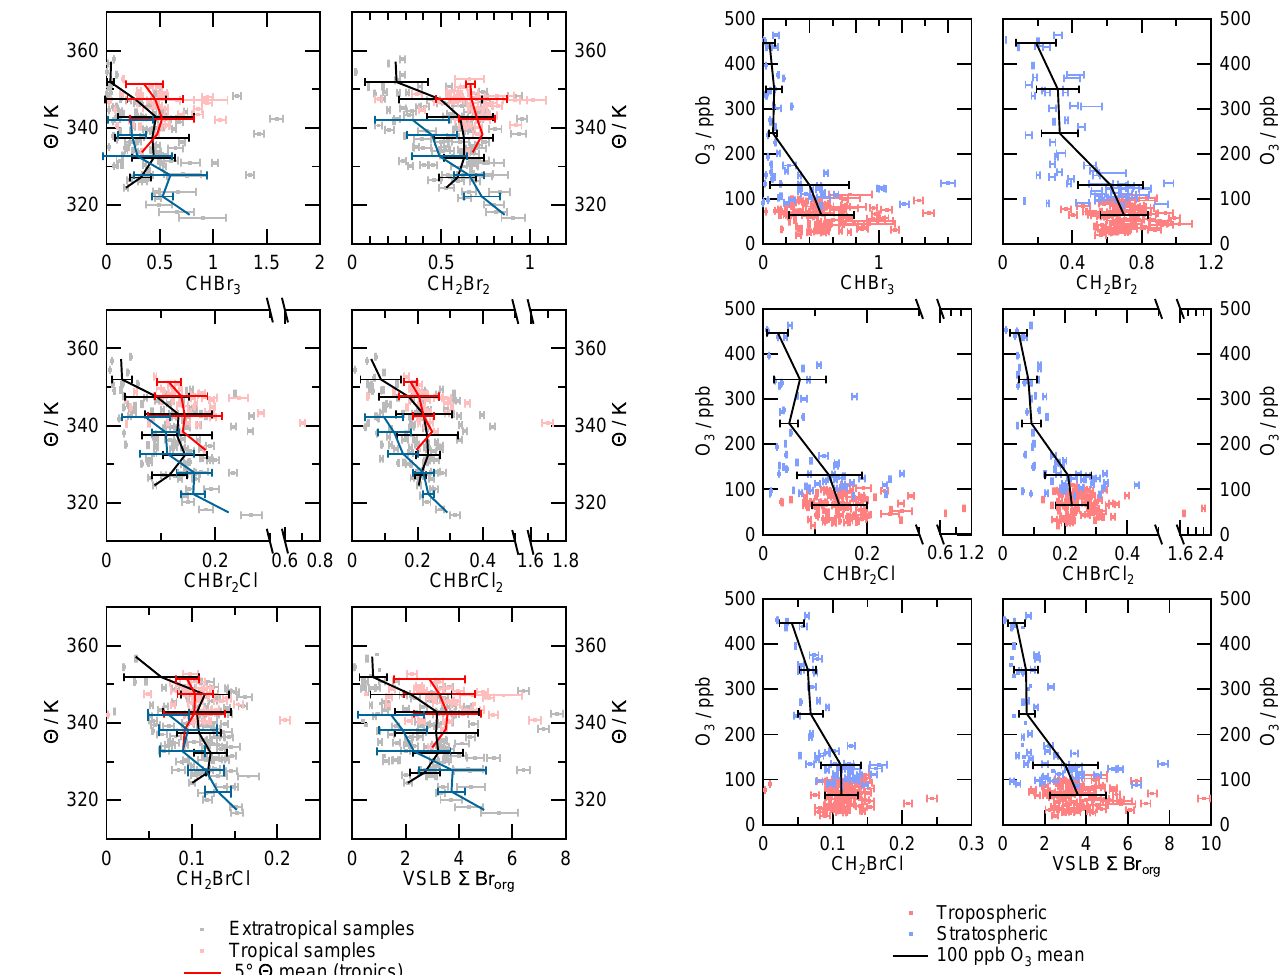
Fig. 5. Plots of VSLB and total VSLB-derived bromine (VSLB 6 Br org ) for all samples on Central American flights against O 3 with 100ppb binned means ± 1 σ error bars representing variability. Er- ror bars on sample data points represent analytical uncertainties. Data points have been separated by colour into tropospheric sam- ples and those with stratospheric influence (see Sect. 3). All VSLB values on the horizontal axes are given in